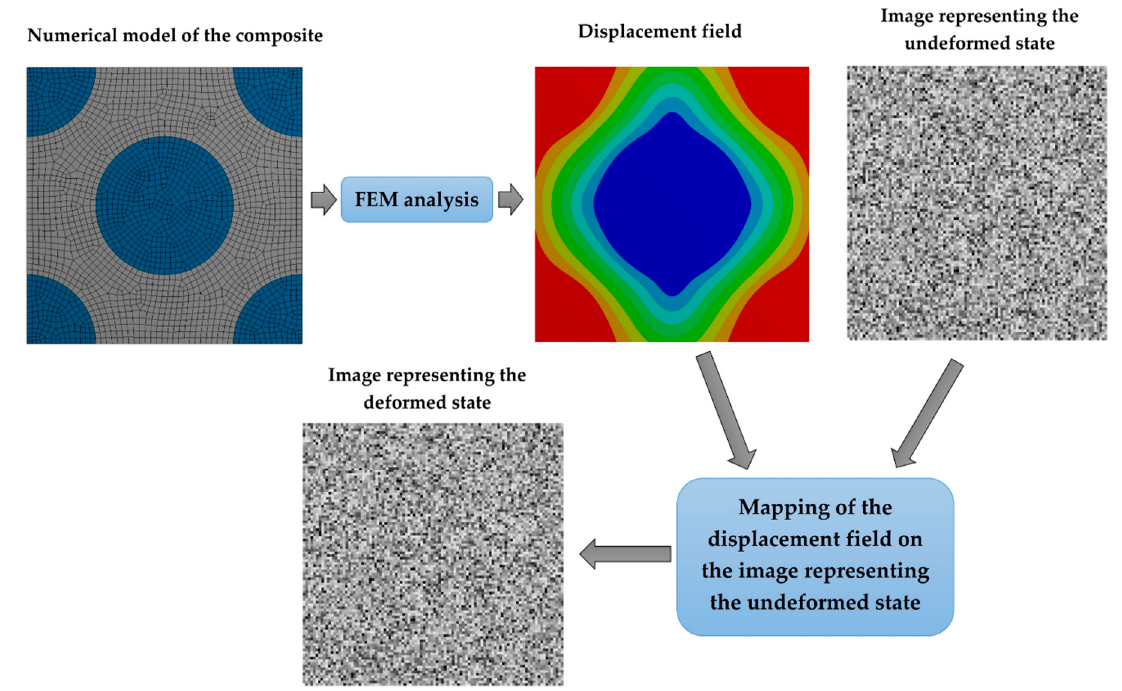
Figure 2. Scheme of generation of artificial speckle patters representing the deformed state.